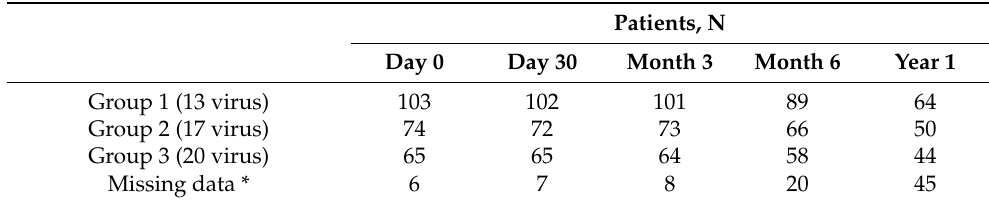
Table 2. Number of patients in groups 1, 2, and 3 for which virological testing was performed at each time-point.